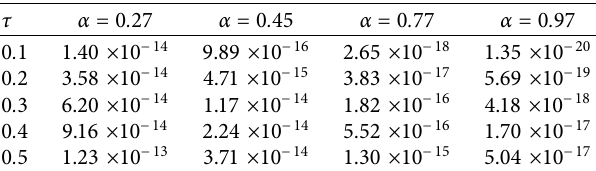
Table 4: He-laplace errors at different values of α when ρ � 0.18 and x � 15 in Example 2. τ α � 0 .